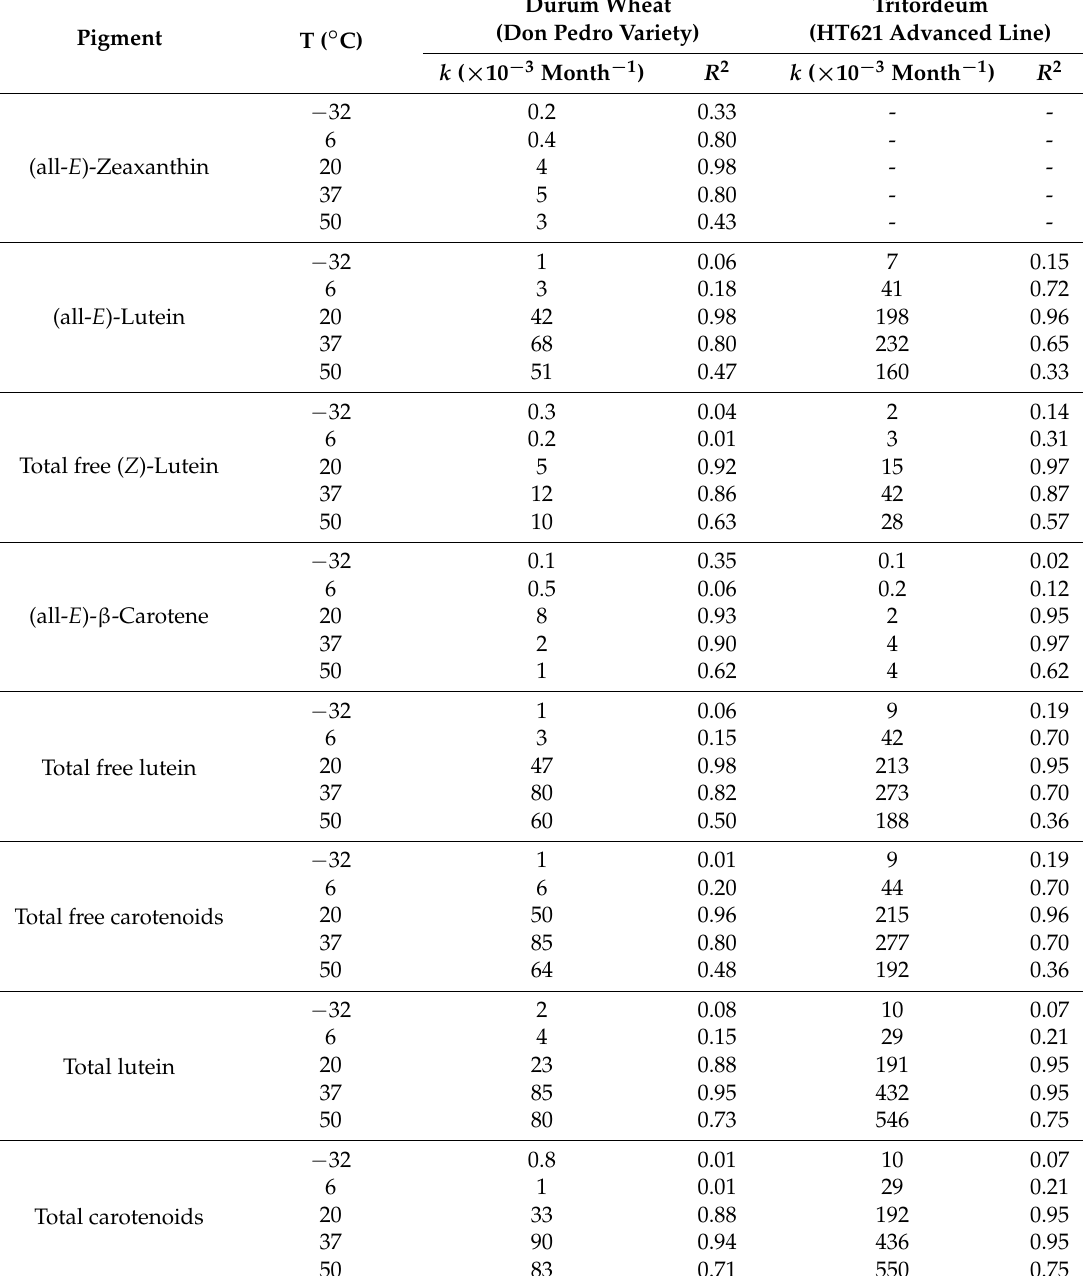
Table 3. Reaction rate constant ( k ; month − 1 ) for the total carotenoid content in durum wheat (Don Pedro variety) and tritordeum (HT621 line) whole-grain flours during a long-term storage period (12 months) at − 32, 6, 20, 37, and 50 ◦ C following the zero-order kinetic model ( C - C 0 = − kt